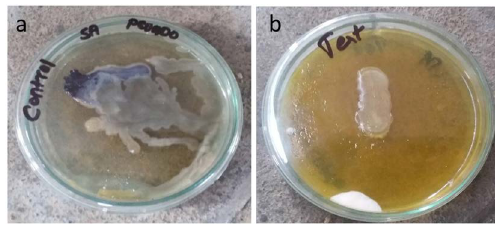
Fig. 1. Swarming motility of Pseudomonas aeruginosa a) Control b) Against